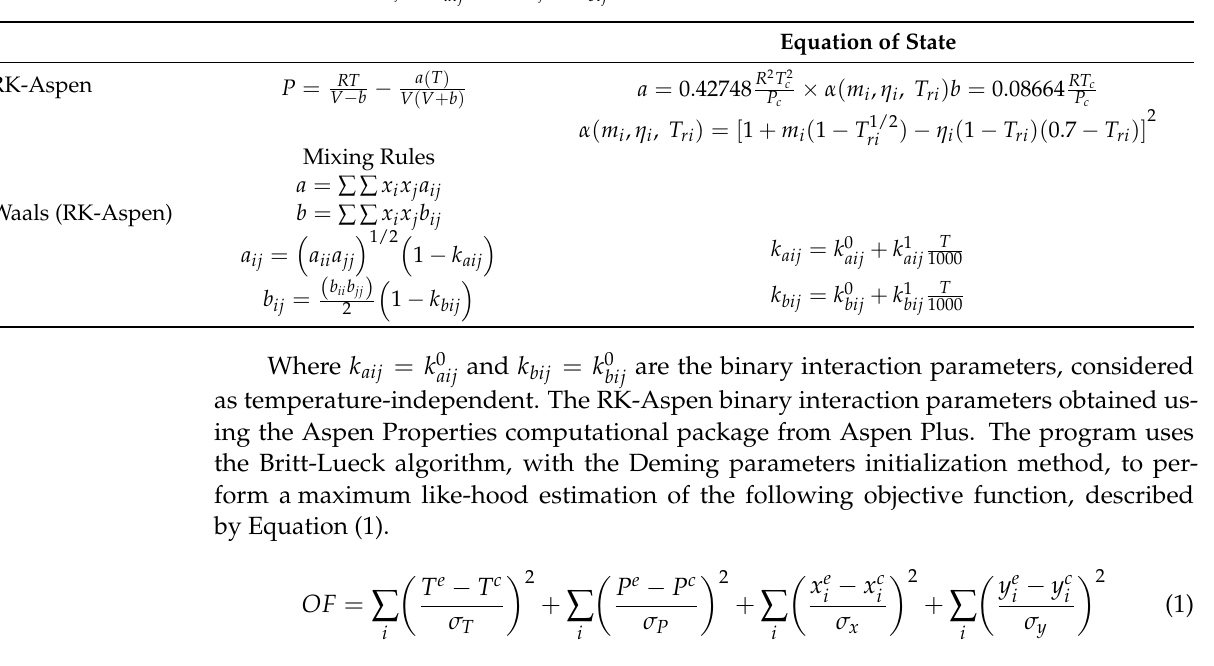
Table 2. The RK-Aspen EOS with the van der Waals mixing rules and RK-Aspen combining rules for two temperature- independent binary interaction parameters k aij = k 0